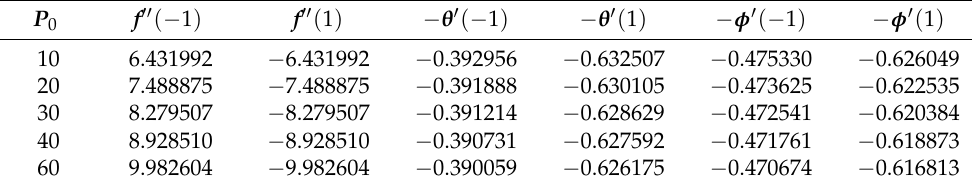
Table 5. Shear stresses, heat and mass transfer rates for various values of P 0